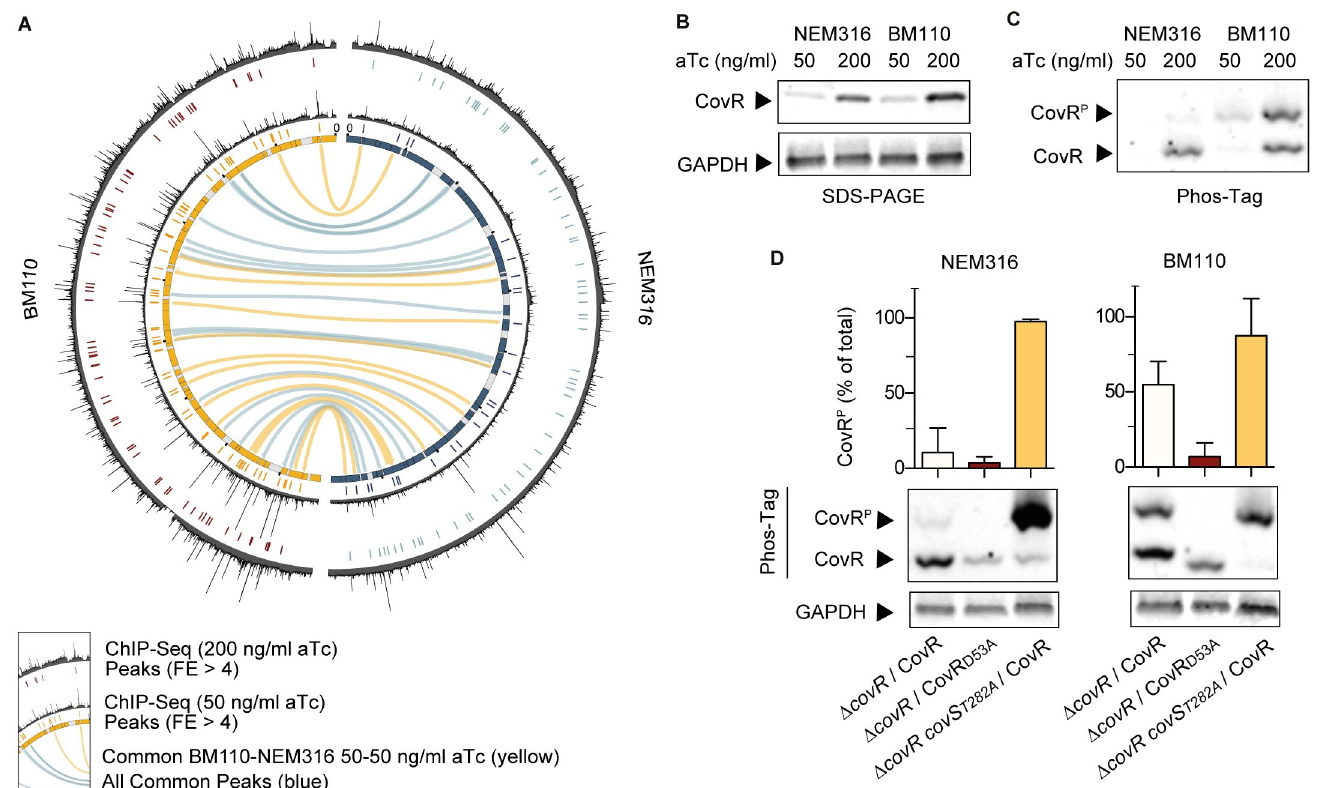
Fig 6. Global effect of CovR phosphorylation on chromosomal binding. (A) Shared CovR binding sites identified on the BM110 and NEM316 chromosomes. The inner circle is a symmetric representation of the BM110 (left, yellow) and NEM316 (right, blue) chromosomes with strain-specific sequences ( < 90% homology) in grey. ChIP-seq profiles for each strain are shown after induction of FLAG-CovR with 50 (inner profile) or 200 (outer profile) ng/ml anhydro-tetracycline (aTc). Significant CovR peaks (FE > 4, IDR < 0.05) are symbolized by colored traits below each ChIP-seq profile. Conserved chromosomal binding loci are represented by the inner connecting lines (in yellow: between ChIP-seq done with 50 ng/ml aTc; in blue: all ChIP-seq experiments). (B) Dose-dependent induction of FLAG-CovR by aTc in BM110 and NEM316 strains. Western blot analysis with anti-FLAG (upper panel) and anti-GAPDH (bottom panel) antibodies after SDS-PAGE electrophoresis of total protein extracts prepared from mid-exponential growing cultures in THY. (C) Level of CovR activation by phosphorylation is strain-specific. The same extracts as in (B) were analyzed with anti-FLAG antibodies after Phos-Tag electrophoresis. A delay migration denotes a phosphorylated form (CovR P ). (D) Quantification of CovS-dependent CovR phosphorylation in NEM316 and BM110. The proportion of phosphorylated epitope-tagged CovR variants were analyzed by Phos-tag analysis after induction with 200 ng/ml aTc. The FLAG-CovR variant was used in the Δ covR (first rows) and Δ covR covS T282A (third rows) mutants, the T282A substitution abolishing the phosphatase activity of CovS. A FLAG-CovR D53A variant (second rows) unable to be phosphorylated by CovS was used in the Δ covR mutants. Quantification are means and standard deviation of 5 biological replicates, and a representative Phos-Tag gel with its GAPDH loading control is presented for each